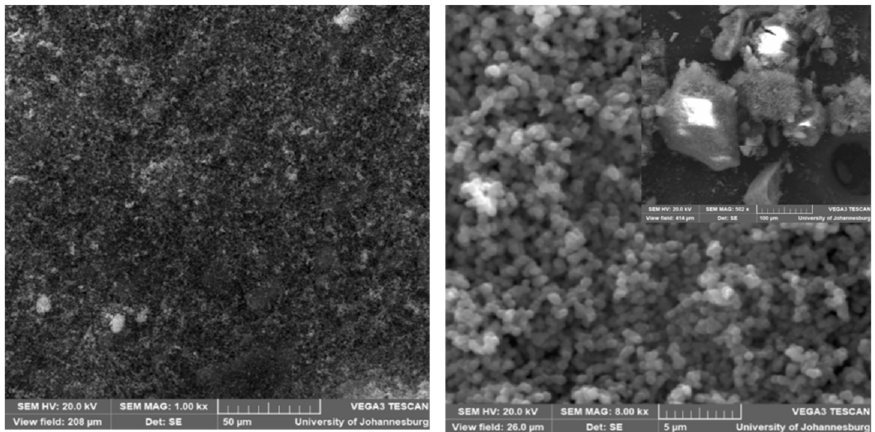
Figure 3. Scanning electron microscopy (SEM) images of ZIF-8 at different